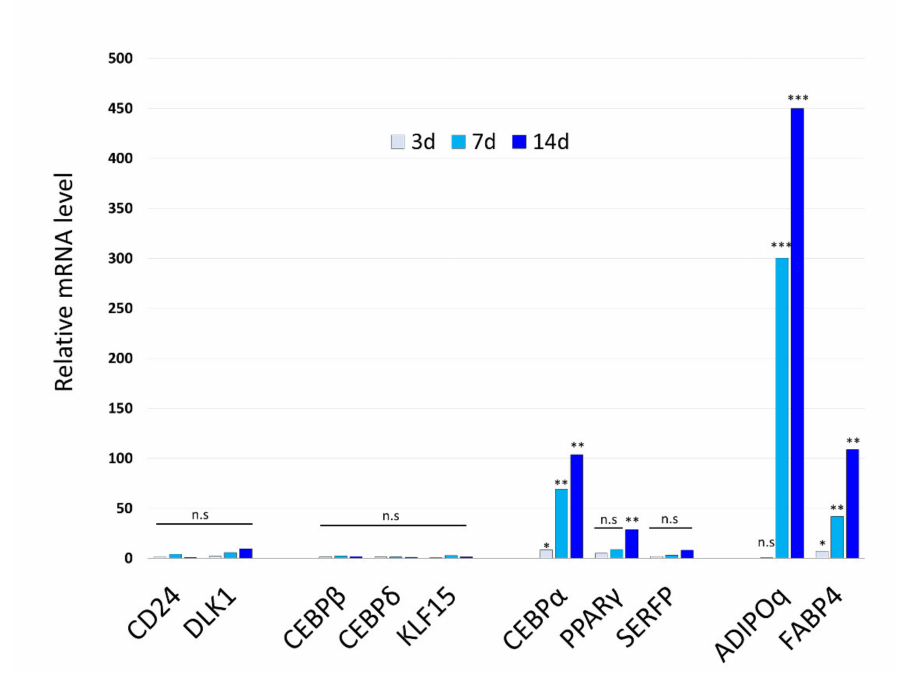
Figure 3. Adipogenic marker genes are induced in HDFs by STK287794. HDFs were cultured in induction medium with or without 1 µ M STK287794. After the indicated number of days, RNA was extracted from the cells and mRNA expression levels for the indicated genes were determined by real-time RT-PCR. Values (mean ± SD) are normalized with respect to the β -actin mRNA level in each sample. Relative values to control (cells cultured without STK287794 for the same period; set to 1.0) are shown ( n = 3 for each group). * p < 0.05, ** p < 0.01, *** p < 0.001 vs. control group. n.s: not